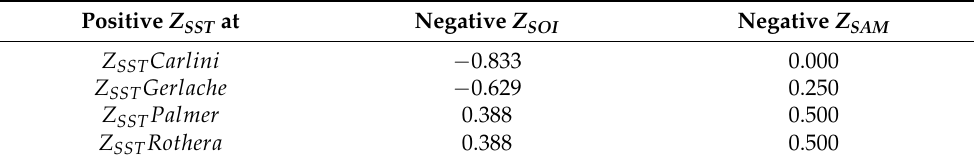
Table 8. Values for the relative power index, Pr index , evaluating the coincidence of low SOI or SAM conditions with high temperatures at each